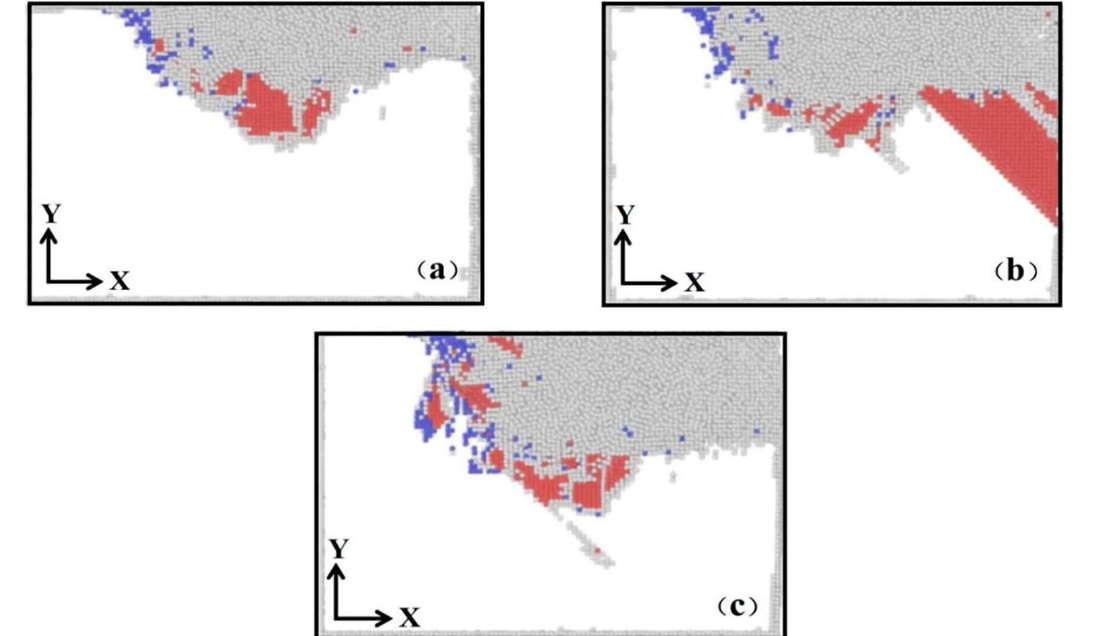
Figure 8. Distribution of subsurface defects at different cutting depths (with water medium) (( a ) cutting depth is 2 nm ( b ) cutting depth is 3 nm ( c ) cutting depth is 4 nm).